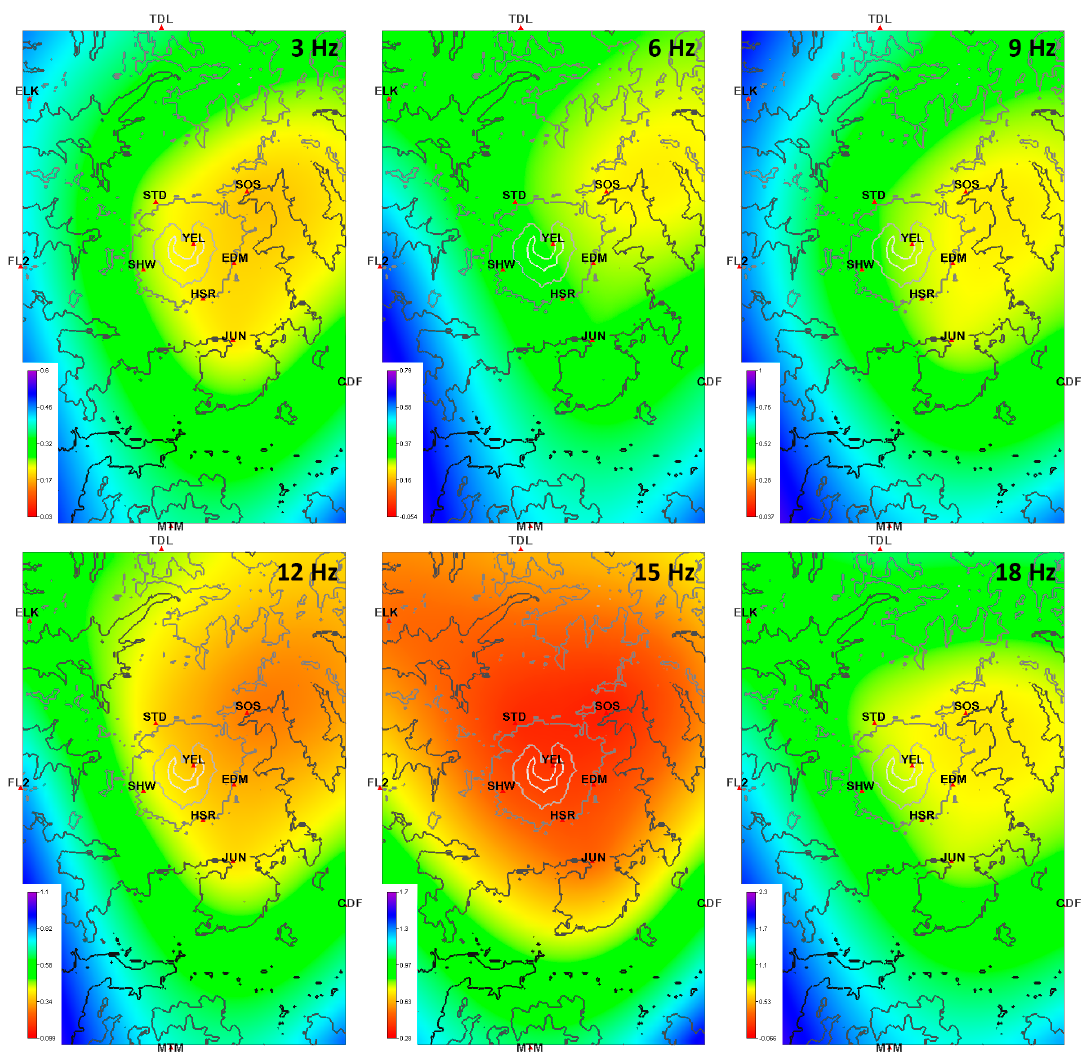
Figure 11. Diffusion (km 2 /s) mapping gridded with a local polynomial method. 3 Hz is associated with a combination of near-receiver coda wave and deeper sampling from the surface wave. Increasing depth is associated with increasing frequency, and so the strongly scattering anomaly observed between 12 Hz and 15 Hz is attributed to a rapidly broadening magma chamber beneath and slightly to the NE of the volcanic